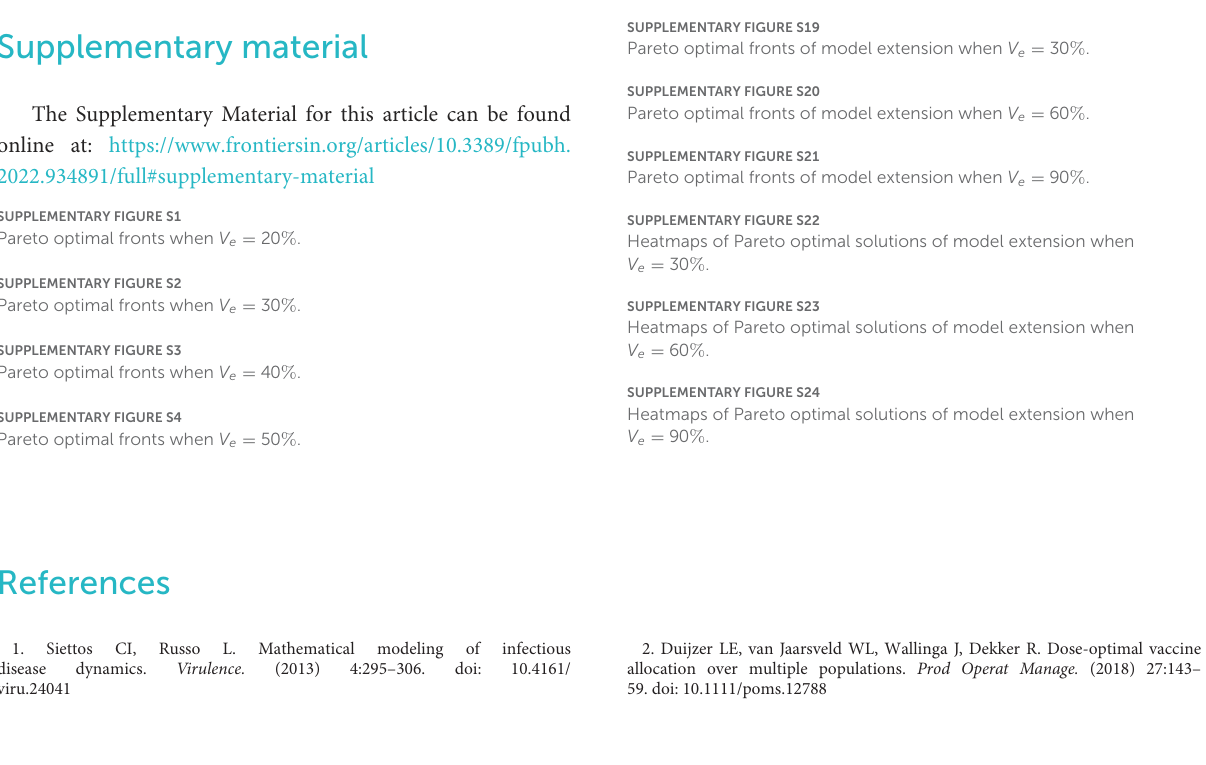
SUPPLEMENTARYFIGURES18 Deaths prevention comparation between chosen optimal strategy and